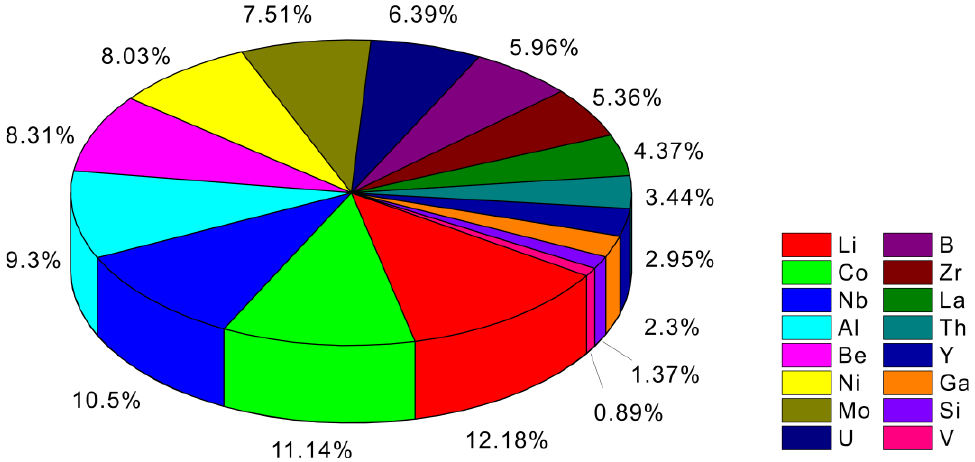
Figure 4. Contributions of individual tracers to the goodness-of-fit of the sediment provenance model.